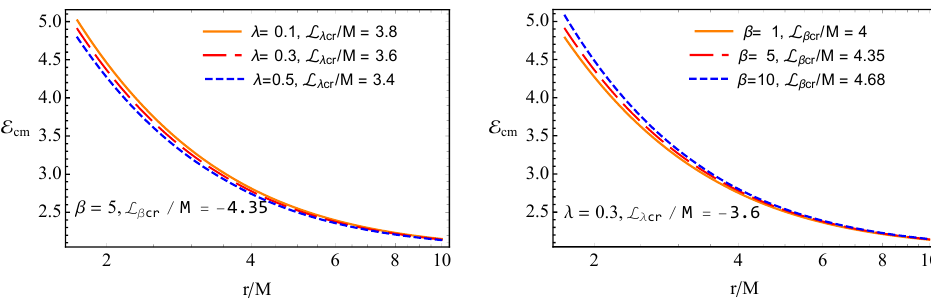
Figure 17. The same figure as Figure 14 but for collisions of magnetically charged particles with magnetized particles. Here, we choose α / M 2 = 0.2 and g / M =